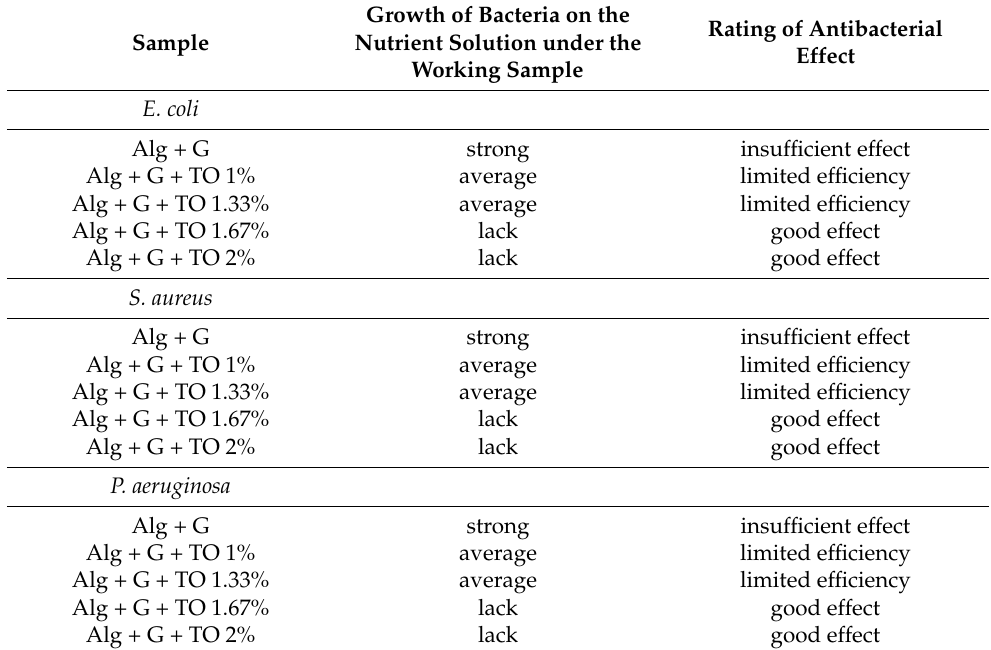
Table 5. The results of antibacterial activity against E. coli , S. aureus , and P. aeruginosa . Growth of Bacteria on Sample